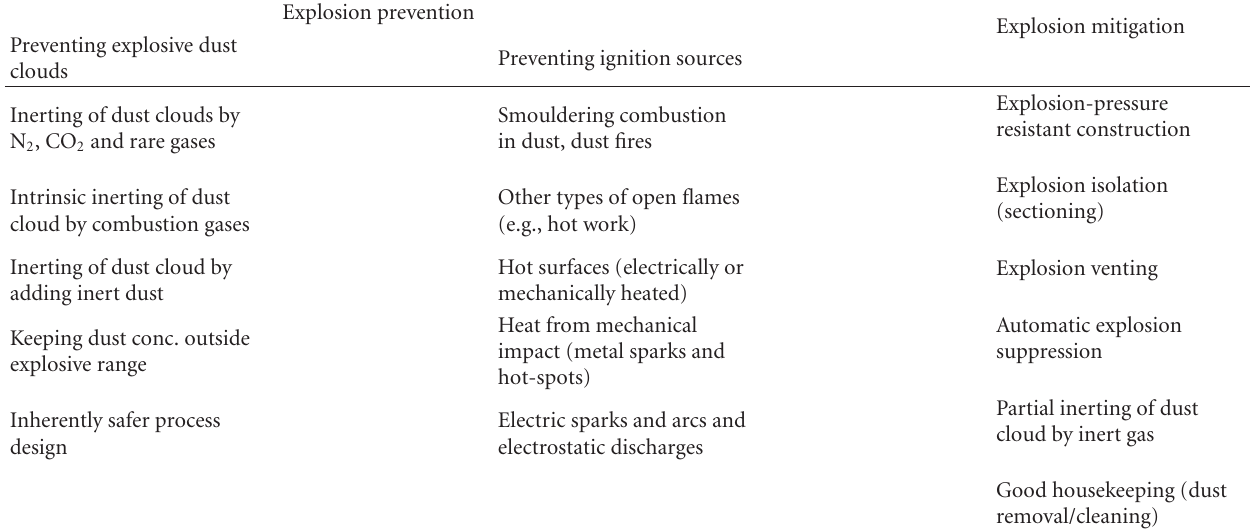
Table 1: Schematic overview of means of preventing and mitigating dust explosions.